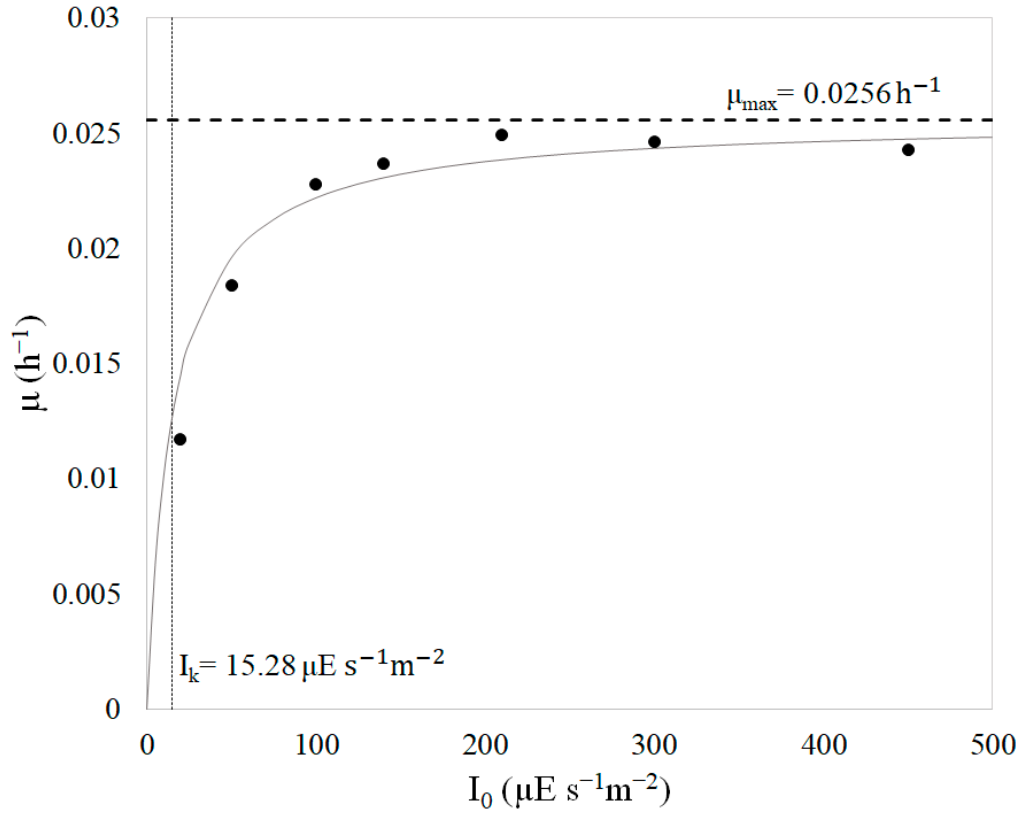
Figure 5. Specific growth rate versus different irradiation intensities of the microalga Nannochloropsis gaditana in the quasi-isoactinic photobioreactor: black circles, experimental data; line, Equation